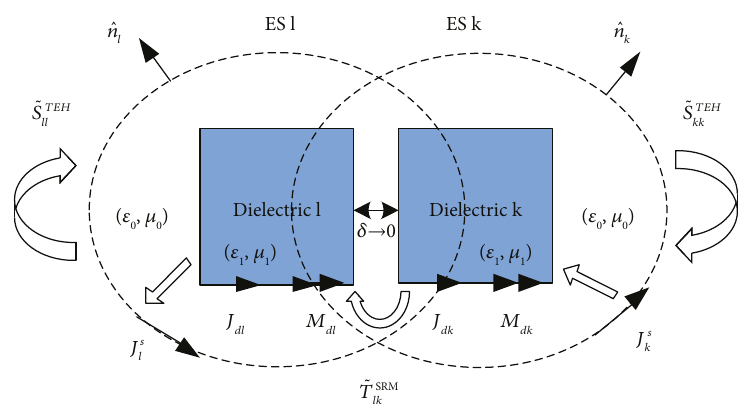
Figure 6: The translation operator of two adjacent